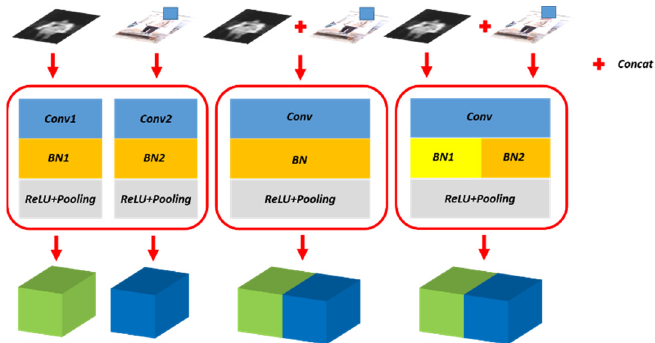
Figure 4. Illustration of the proposed separate batch normalization layer. The left shows two segmentation networks for PMMWI and VI respectively, and the middle employs one network for PMMWI and VI segmentation. The right is our method. We introduce two independent BN layers to learn PMMWI and VI features respectively, while the remaining of the network is shared.